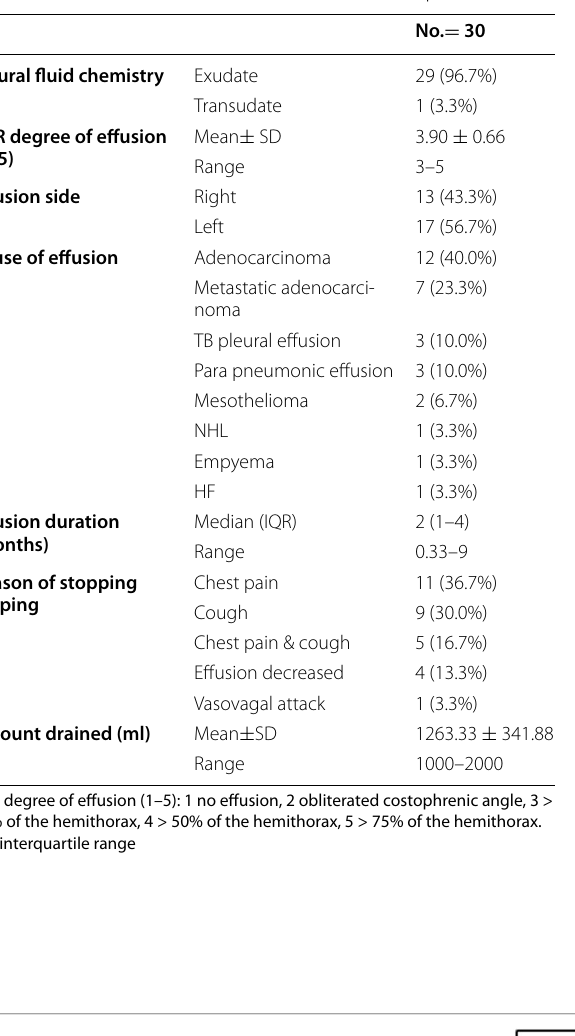
Table 3 Pleural fluid characteristics of the studied patients